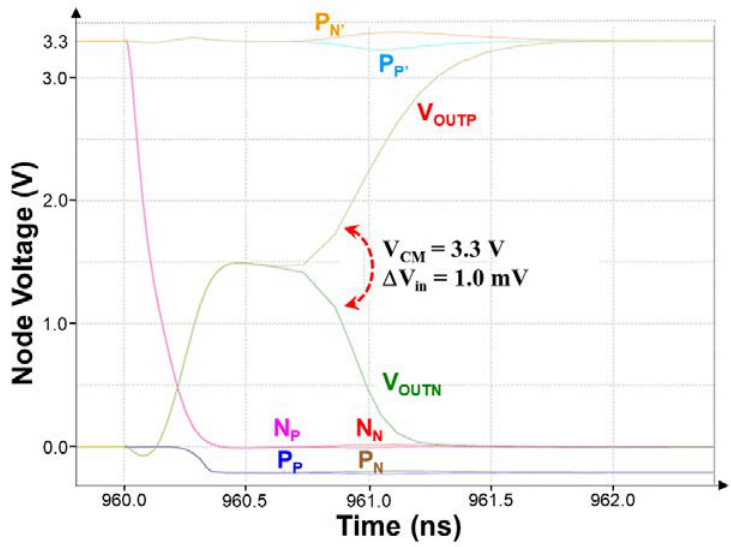
Figure 12. Simulation waveforms of the proposed comparator with V CM = 3.3 V and ∆ V in = 1.0 mV.